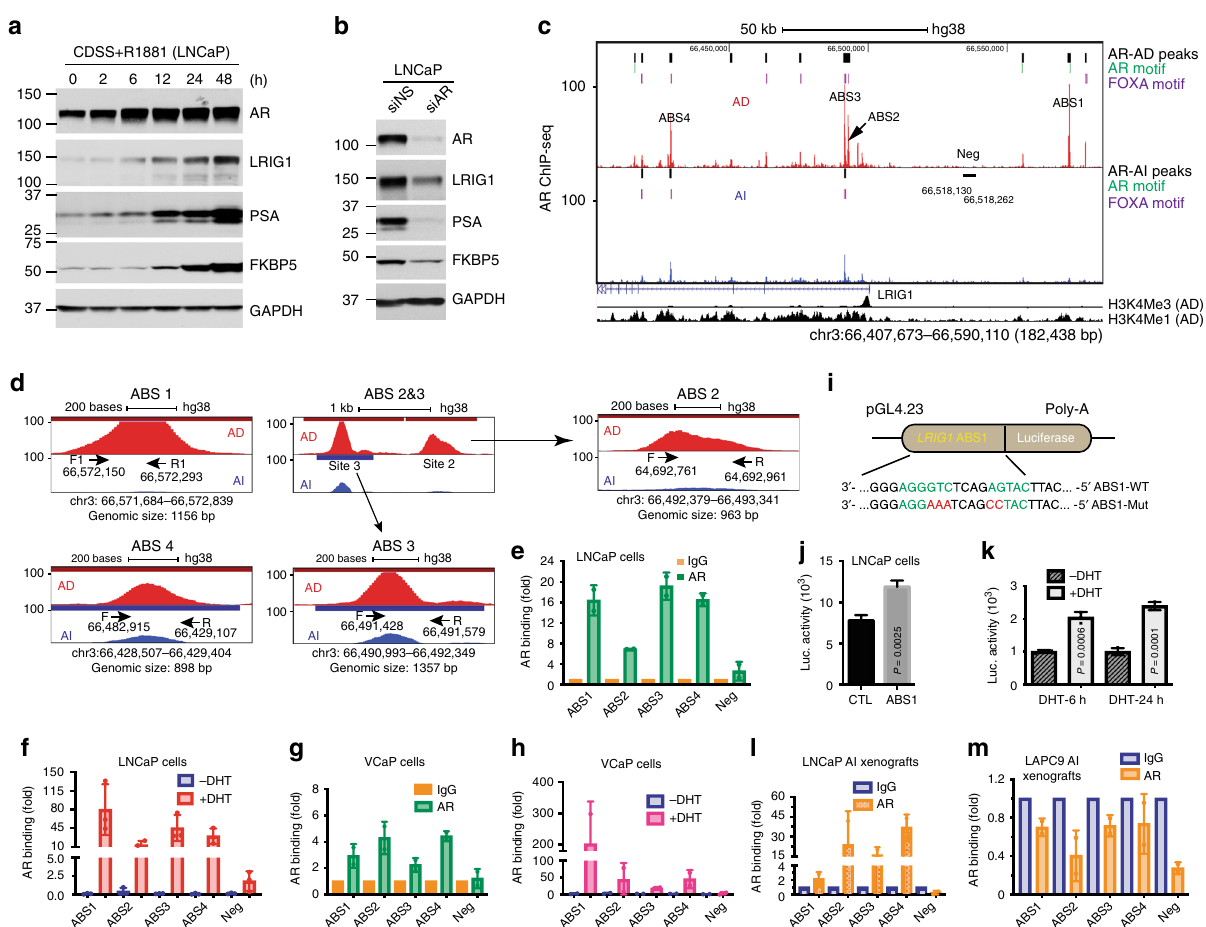
Fig. 7 LRIG1 is directly regulated by AR in PCa cells. a R1881-induced AR is accompanied by increased LRIG1 and other AR targets. LNCaP cells cultured in CDSS (48 h) were treated with R1881 (0.1 nM) for the intervals indicated. b AR knockdown reduces LRIG1 and AR targets. LNCaP cells were treated by AR- targeting siRNAs (10 nM; 48 h), and whole cell lysate used in WB. c AR binds to multiple ABS in LRIG1 genomic locus. Shown on top are 4 major potential ABS in AD LNCaP cells identi fi ed by AR ChIP-seq (Neg: genomic region used as negative control in ChIP-qPCR). Shown on right are AR peaks (AD, top; AI, bottom) and canonical AR and FOXA motifs. Shown below are H3K4me3 and H3K4me1 peaks in LNCaP AD cells. d Zoom-in presentation of potential AR binding sites (ABS1-4; sizes indicated below) in the LRIG1 genomic region. For each ABS, the primers (F, forward primer; R, reverse primer) used for ChIP- qPCR were indicated with arrows. e , f ChIP-qPCR analysis of AR binding to ABS1 – 4 in regular ( e ) or DHT-stimulated ( f ) LNCaP cells. AR binding to ‘ Neg ’ region was used as control and ChIP results were normalized to IgG. Bars represent the mean ± S.D ( n = 3). g , h ChIP-qPCR analysis of AR binding to LRIG1 genomic region in VCaP cells. Shown are ChIP-qPCR results of AR binding to ABS1-4 in regular VCaP ( g ; normalized to IgG) or VCaP cells stimulated with DHT (10 nM, 2 h; normalized to -DHT) ( h ). Bars represent the mean ± S.D ( n = 3). i Schematic of LRIG1 -ABS1 pREPORT luciferase constructs. A wild-type (WT) or mutated (Mut) LRIG1 -ABS1 fragment (~100 bp) that harbors an ARE (AR-Responsive Element) was used to drive luciferase expression. j , k Luciferase assays of ABS1 in LNCaP cells ( j ) and responsiveness of ABS1-luc to DHT ( k ) (mean ± S.D; n = 3). P -values (Student ’ s t -test) are indicated. l , m ChIP-qPCR analysis of AR binding to LRIG1 ABS1-4 in LNCaP ( l ) and LAPC9 ( m ) AI xenografts. All results were normalized to IgG (mean ± S.D; n = 3). *Source data for Fig. 7 (representative gel images) are provided as a Source Data fi